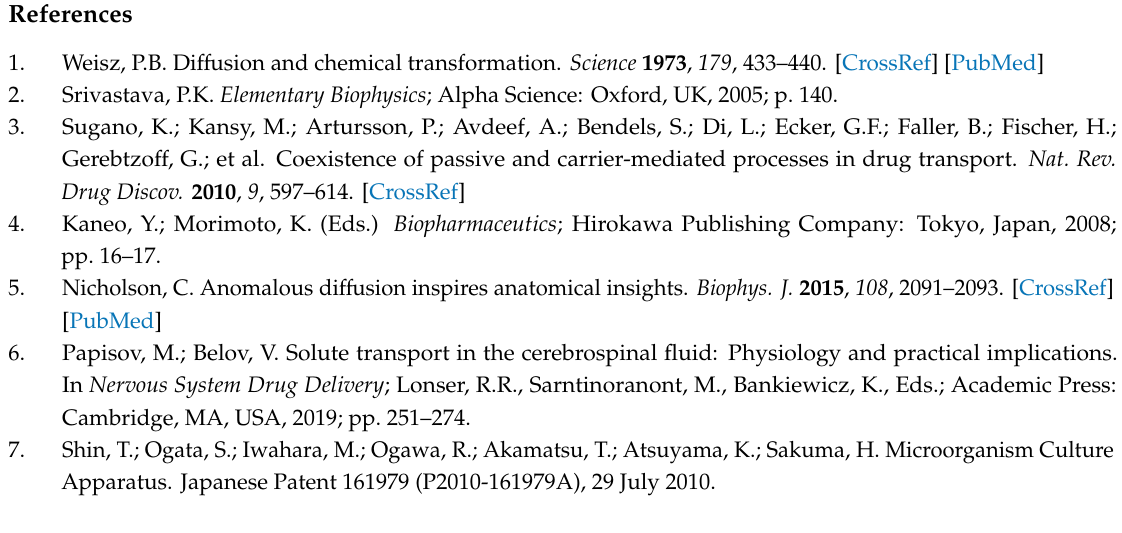
Supplementary Materials: The following are available online, Table S1: Relative energies and Boltzmann populations of stable conformers of xylose, Table S2: Relative energies and Boltzmann populations of stable conformers of fructose, Table S3: Relative energies and Boltzmann populations of stable conformers of galactose, Table S4: Relative energies and Boltzmann populations of stable conformers of glucose, Table S5: Relative energies and Boltzmann populations of stable conformers of sucrose, Table S6: Relative energies and Boltzmann populations of stable conformers of lactose, Table S7: Relative energies and Boltzmann populations of stable conformers of trehalose, Table S8: Relative energies and Boltzmann populations of stable conformers of maltose, Table S9: Relative energies and Boltzmann populations of stable conformers of alanine, Table S10: Relative energies and Boltzmann populations of stable conformers of proline, Table S11: Relative energies and Boltzmann populations of stable conformers of threonine, Table S12: Relative energies and Boltzmann populations of stable conformers of leucine, Table S13: Relative energies and Boltzmann populations of stable conformers of aspartic acid, Table S14: Relative energies and Boltzmann populations of stable conformers of arginine, Table S15: Relative energies and Boltzmann populations of stable conformers of aspirin, Table S16: Relative energies and Boltzmann populations of stable conformers of salbutamol, Table S17: Relative energies and Boltzmann populations of stable conformers of loxoprofen, and Table S18: Relative energies and Boltzmann populations of stable conformers of Fast Green FCF. MolFiles: The cartesian coordinates of all the conformers of each molecule listed in Table